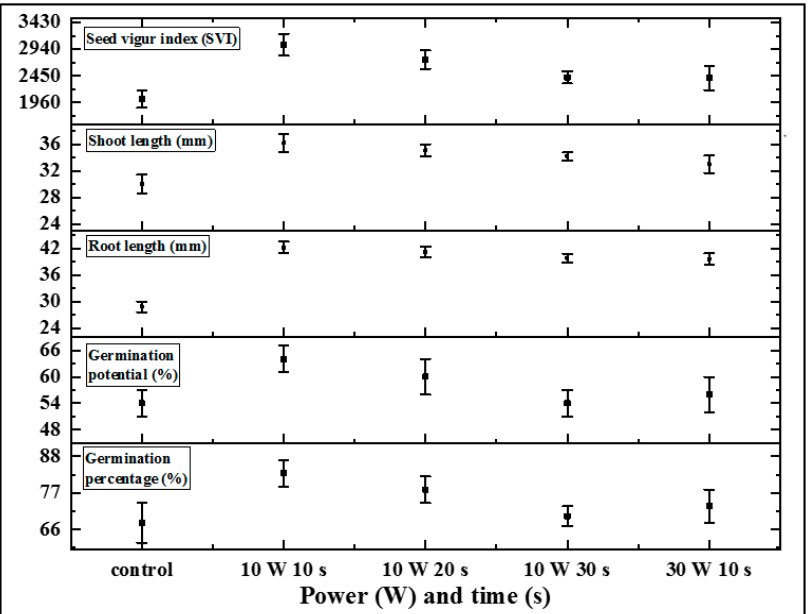
Figure 2. Germination potential (%, first count, day 5), germination percentage (%, final count, day 8), root length (mm), shoot length (mm), and seed vigor index (SVI) of Bambara groundnut seeds (H 2 O-plasma-treated and control). Experiments were performed in five replicates, n = 5 (note: 20 seeds weighing ~ 5 g were used per replicate). Error bars refer to the standard deviations of the five replicates.